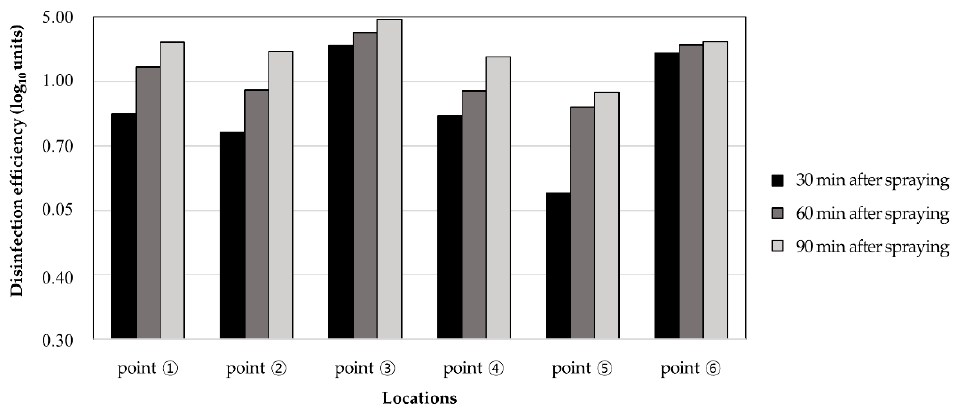
Figure 5. Disinfection efficiency (log 10 units) of total bacteria on indoor surfaces by locations and time after spraying.